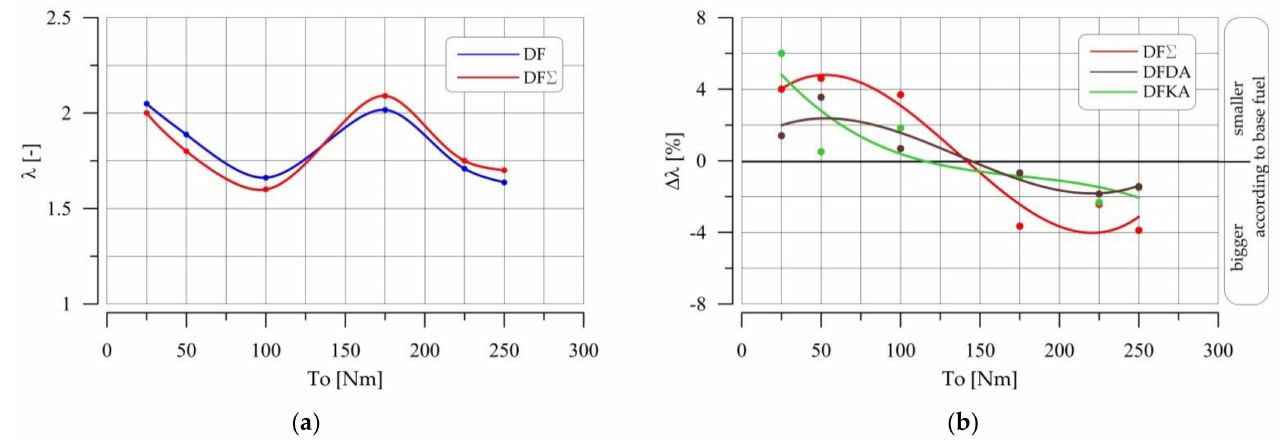
Figure 8. ( a ) Excess air coefficient ( λ ) vs. engine torque; ( b ) Percentage difference in the values of the excess air coefficient ( λ ) vs. engine torque in relation to the base fuel.